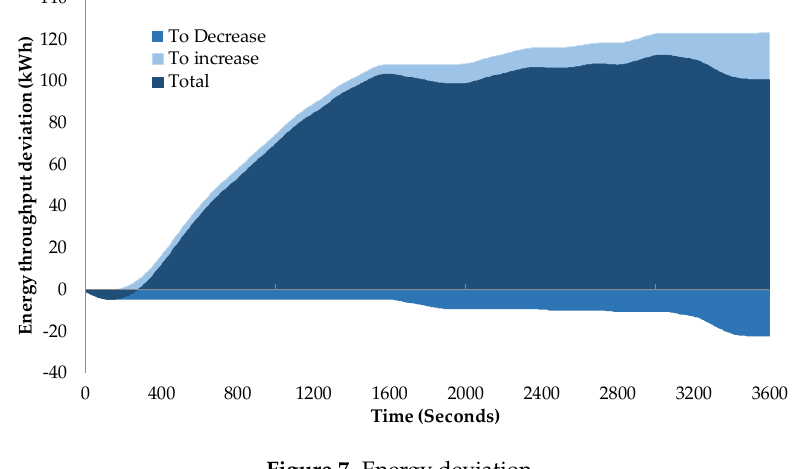
Figure 7. Energy deviation.